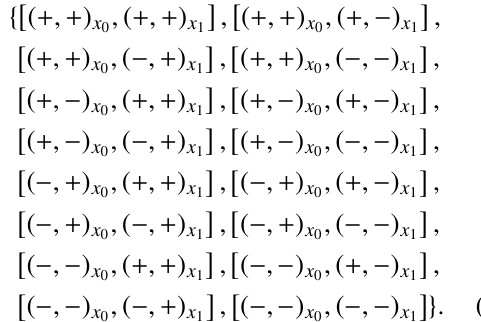
Figure 13: The Mach-Zehnder interferometer used in the ex- ample of Hardy’s